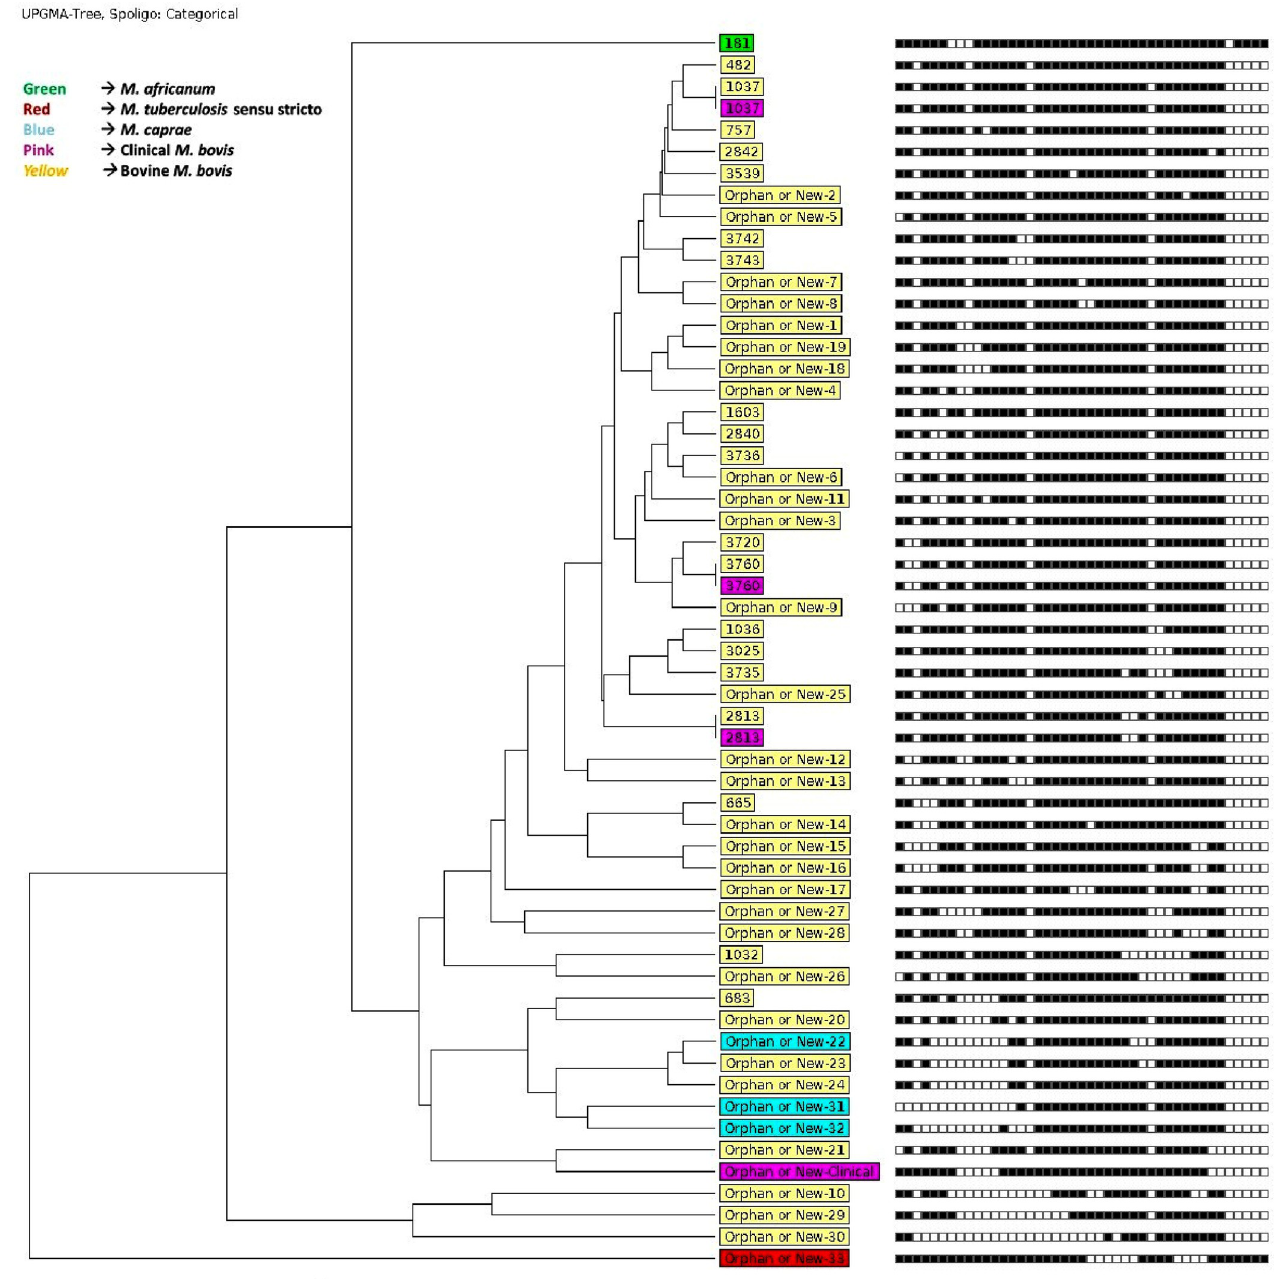
Fig 8. Phylogenetic relationship between M . bovis isolates from both bovine and humans (clinical). In all, 3 out of the four clinical M . bovis isolates (pink) had the same spoligotype patterns as the bovine isolates. The three M . caprae with distinct patterns (blue) were isolated from bovine source. Two human- adapted MTBCs were isolated from the bovine source; one Maf L6 (Green) and one Mtbss L4 (Red, Cameroon). The labels on the leaves represent the SIT